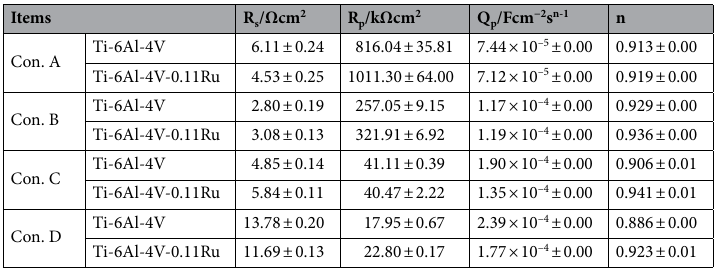
Table 2. Electrochemical parameters of different titanium alloys under various test